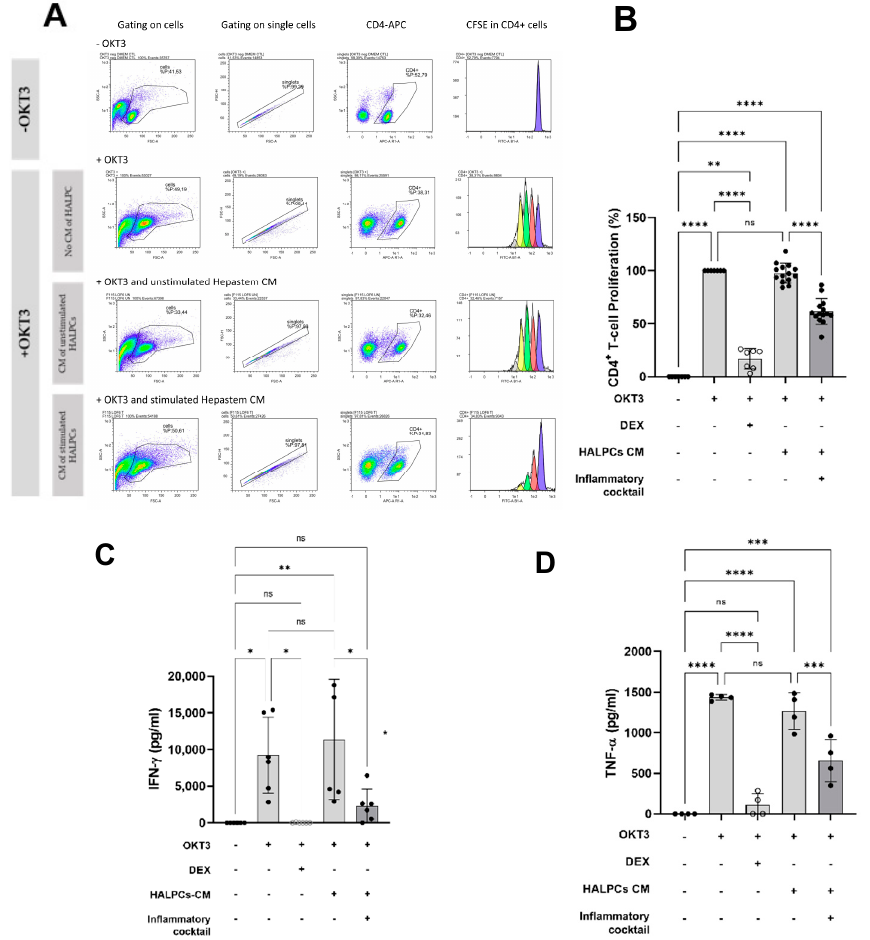
Figure 2. Effect of HALPCs conditioned medium on APC-induced T-lymphocyte proliferation. ( A ), Representative experiment showing the plot for the different control and tested conditions: Scatter plot FSC/SSC, singlets, CD4 + T cells, CFSE staining. The number of peaks